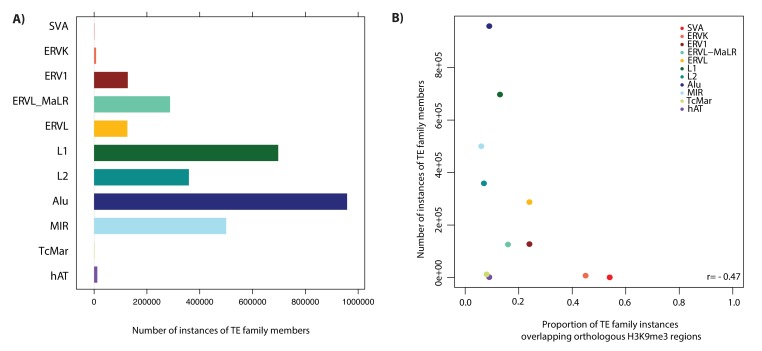
TE copy number is weakly anti-correlated with silencing by H3K9me3.(A) The number of instances of all family members within a TE family. (B) The relationship between the proportion of TEs in each family that overlap an orthologous H3K9me3 region, and the number of instances of TE family members. Pearson’s correlation coefficient is represented as r.